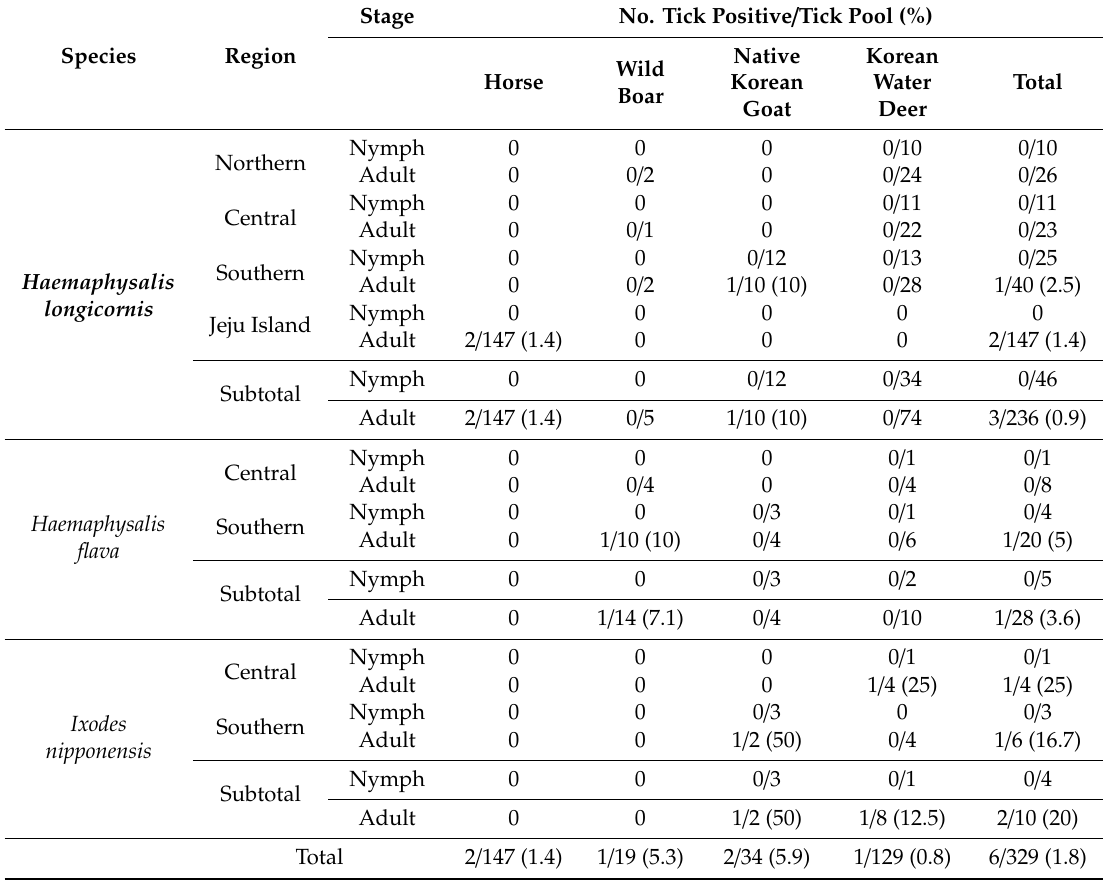
Table 1. Prevalence of Borrelia afzelii detected by PCR in ticks collected from several mammals in South Korea,